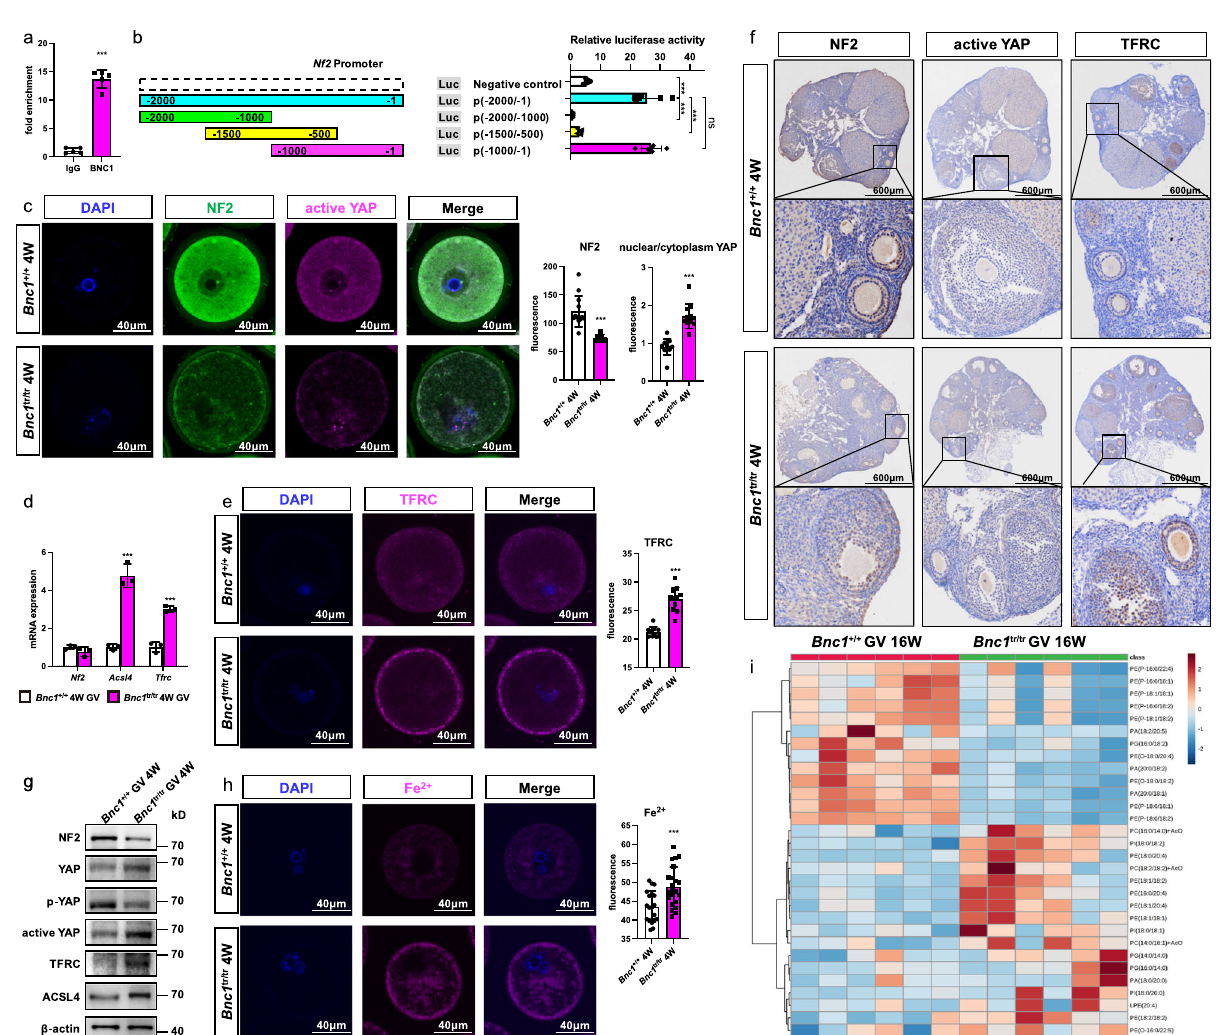
Fig. 6 | Bnc1 truncation mutation sensitizes oocytes to ferroptosis by regulat- ing NF2-YAP signaling. a ChIP – qPCR for BNC1 at Nf2 promoter using mouse ovaries ( n =5, p value<0.0001, 3 independent experiments). b Dual luciferase reporter assay of Bnc1 at the Nf2 promoter ( n =6, the error bars indicate the mean values±SDs, unpaired t test, two-tailed, p value<0.0001, 3 independent experi- ments). c NF2 and active YAP in GV oocytes at 4 weeks old (the error bars indicate the mean values±SDs, unpaired t test, two-tailed, p value<0.0001 for NF2,